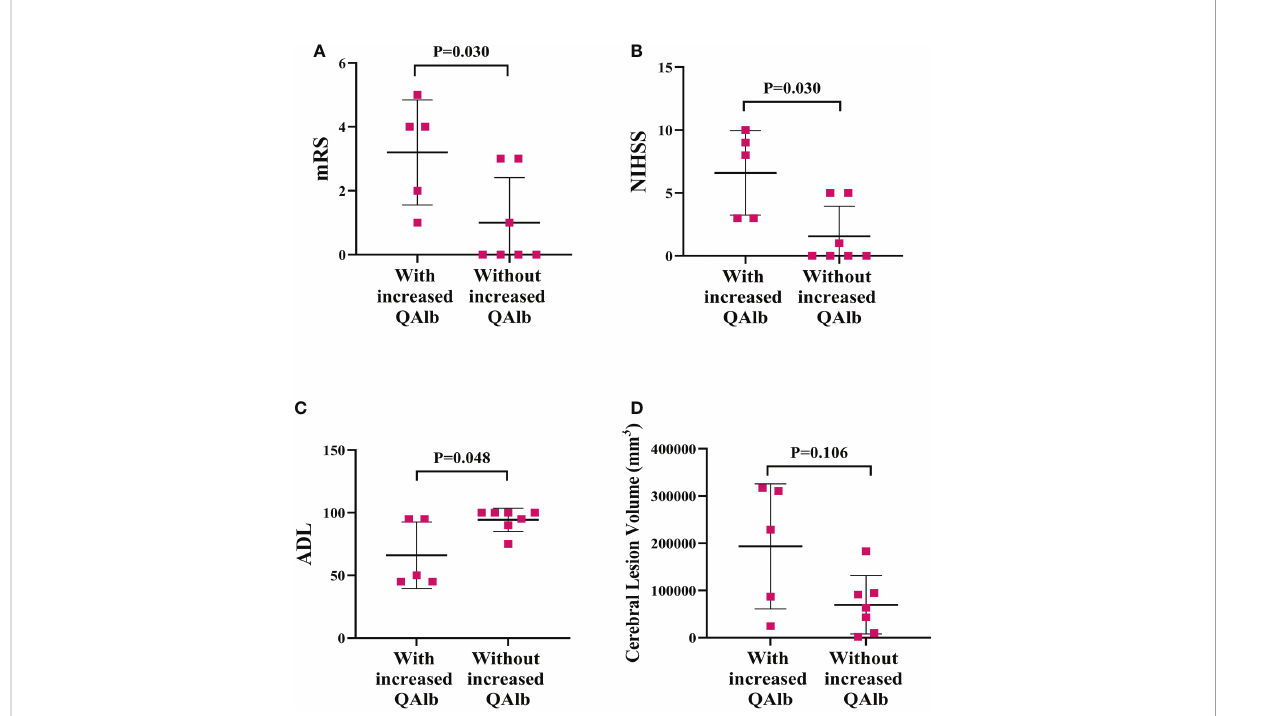
FIGURE 9 More serious disease performance and cerebral lesion volume in PACNS patients with increased QAlb. (A – C) The mRS and NIHSS were signi fi cantly higher and ADL was signi fi cantly lower in PACNS patients with increased QAlb (n=5) than patients without increased QAlb (n=7). (D) In the PACNS patients with increased QAlb (n=5), levels of cerebral lesion volume appeared to be signi fi cantly higher than in those without